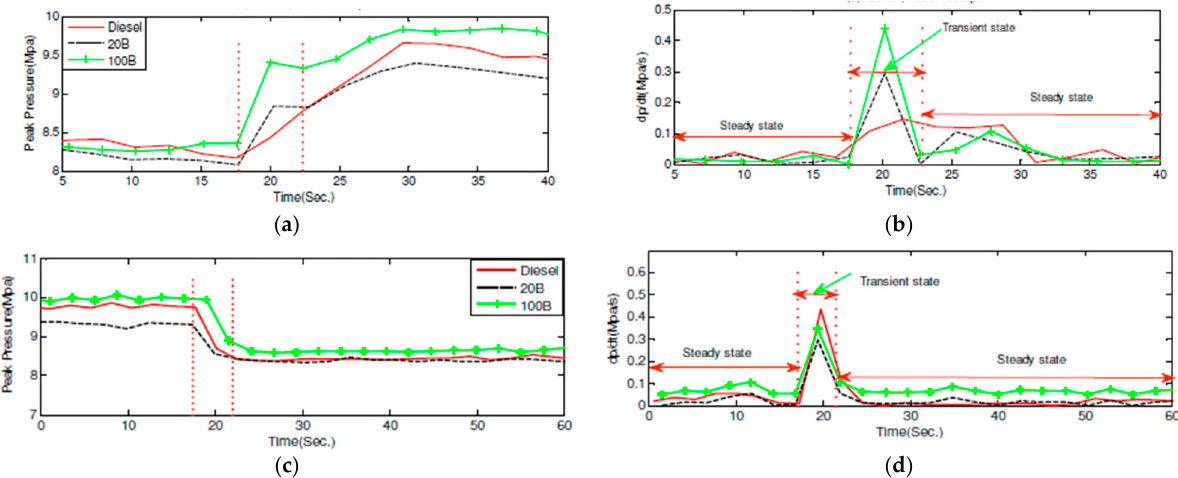
Figure 7. ( a ) In-cylinder peak pressure vs. time for CI engines running with different fuels during the positive speed transient and the ( b ) corresponding in-cylinder peak pressure at positive speed transient. ( c ) In-cylinder peak pressure during negative speed transient and the ( d ) corresponding rate of change of in-cylinder peak pressure vs. time during the negative speed transient.